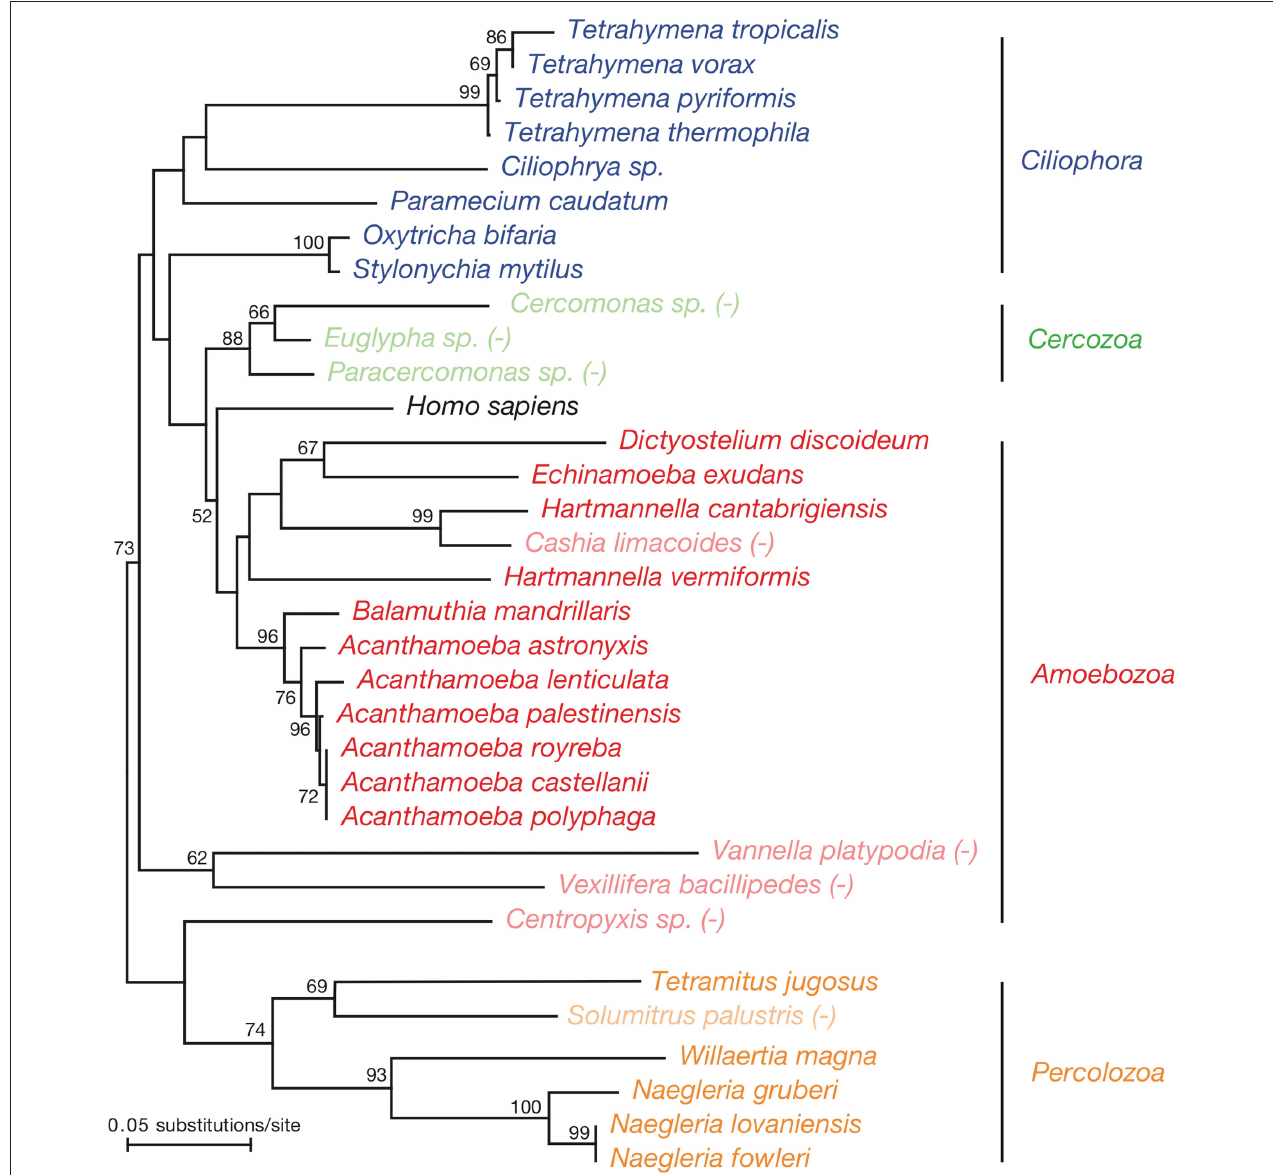
FIGURE 1 | An 18S phylogenetic tree of the experimentally defined hosts of L. pneumophila . Evolutionary history was inferred using the Neighbor-Joining method based on an alignment of 18S rRNA sequences. Evolutionary analyses were performed using MEGA7 (Kumar et al., 2016). Restrictive host species that do not support L. pneumophila replication or survival are indicated by lighter shading and the annotation “( − )”. Taxonomic designations are based on the classification system outlined in Ruggiero et al.